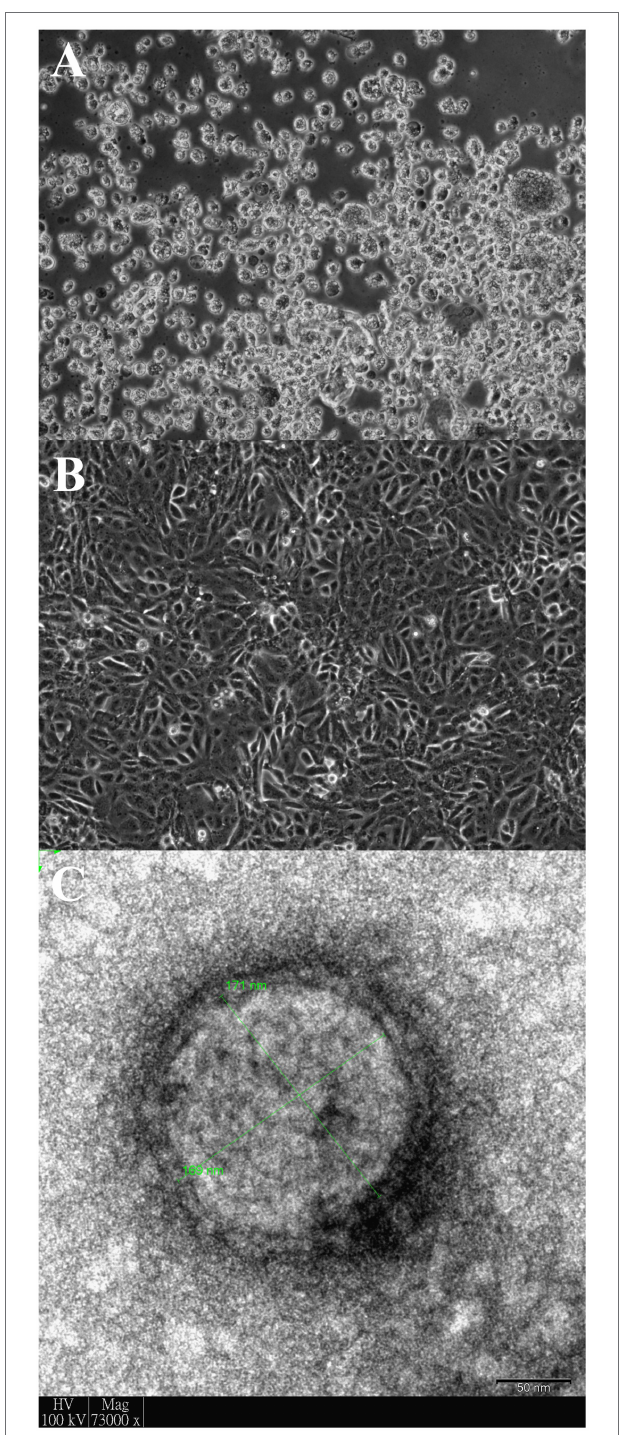
FIGURE 1 | Vero cells infected with dromedary camel parainfluenza virus 3 (DcPIV3; D1189.8). Light micrograph showing cytopathic effects (CPEs) of D1189.8 culture isolate from the camel calf of a dromedary on (A) Vero cells; (B) Uninfected control of Vero cells. Magnification: ×100 and (C) DcPIV3 (D1189.8) viral particle stained with phosphotungstic acid under transmission electron microscope. The size of the displayed viral particle is about 170 nm. Scale bar represents 50